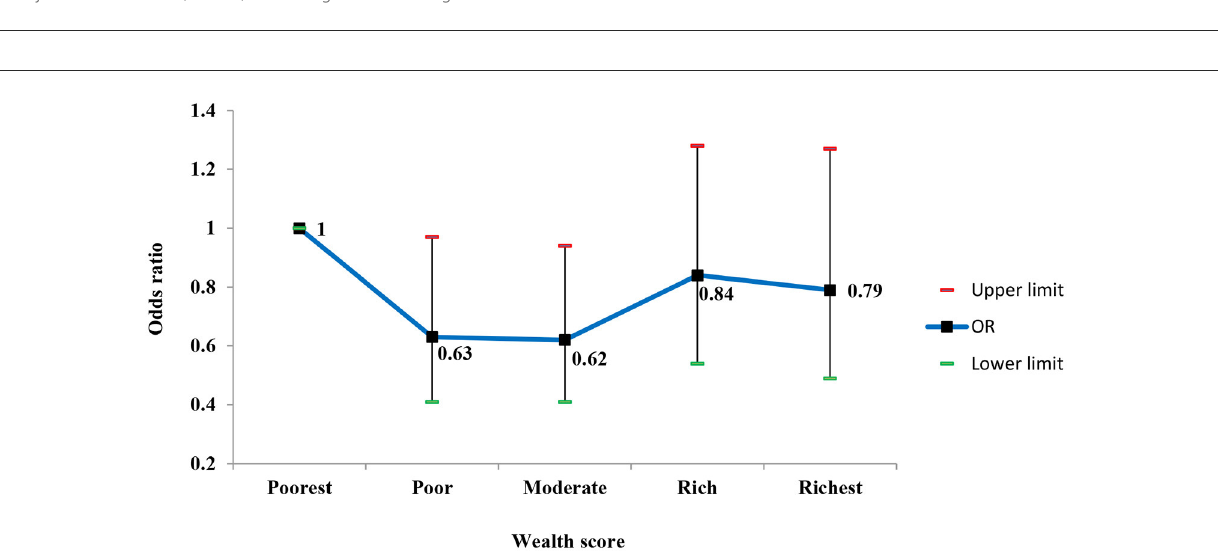
FIGURE2 Adjusted odds ratios (95% CI) of hearing loss according to wealth